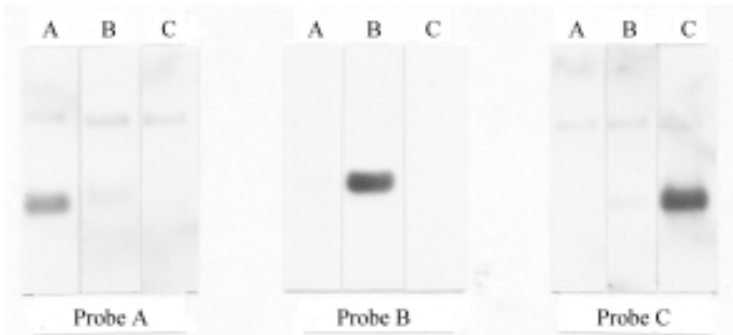
Figure 2 - Southern blot analysis of tortoise cDNAs. Tortoise cDNAs of CaM-A , -B , and -C were digested with Xba I and EcoR I restriction enzymes, and threesetsofdigestedDNAsunderwentelectrophoresisandwerethenblottedontomembrane.LanesA,BandCindicatecDNAsof CaM-A , -B and -C ,re- spectively. Probes A, B, and C indicate a random hexamer-primed 32 P-labeled DNA probe of, respectively, the CaM-A , -B , and -C coding regions. Each CaM-A , -B , and -C probe could detect its own clone, but not others. Faint signals were visible in the position of vector plasmid pUC19 in probes A and C, and slight cross-hybridizations between CaM-B and probes A and C were also detectable.